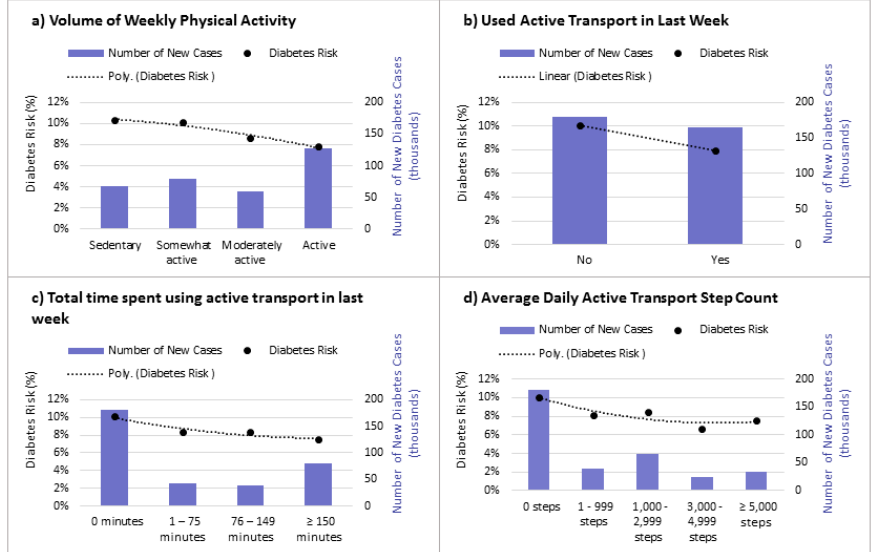
Figure 2. 10-year DPoRT estimated diabetes risk and new cases (2015/16–2025/26) according to: ( a ) weekly physical activity level; ( b ) active transport use in last week; ( c ) total minutes spent using active transport in past week; ( d ) average daily active transport step count.